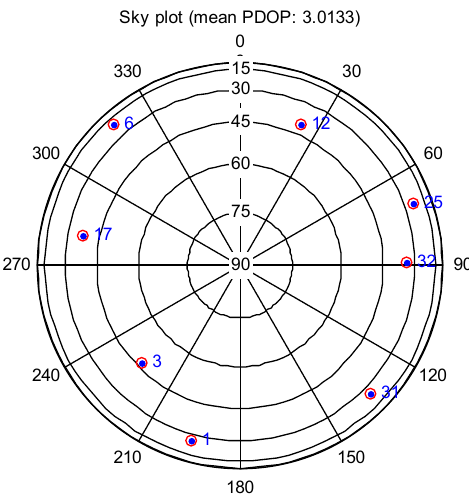
Figure 5. Sky plot of GPS satellites in polar areas.